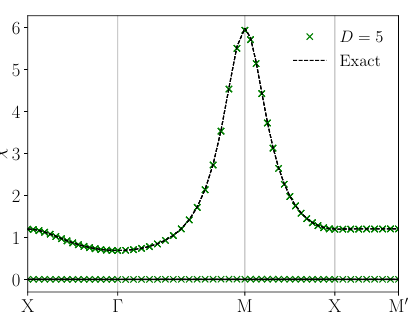
Figure 7: Physical lattice susceptibility χ ( q ) computed for the single-band Hubbard model on the square lattice at U = 1.5 W and β = 2.5. We used D = 5. Different branches correspond to different eigen modes of χ ( q ,0 ) , i.e., the spin susceptibility and the charge susceptibility.